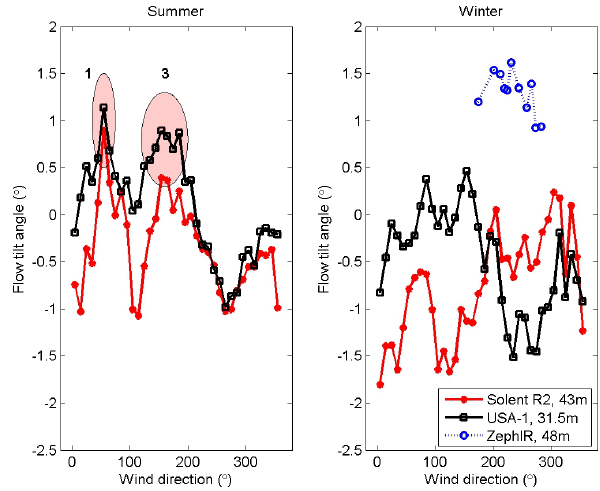
Fig. 6. Comparison of directional responses for the two sonic anemometers during summer (left) and winter (right). The result from the ZephIR lidar measured during the winter of 2006 (Dell- wik et al., 2010b) at 48m is also shown. The numbers at the ovals indicate an influence from an upstream or downstream forest edge, where the numbers refer to the listed features in Fig.